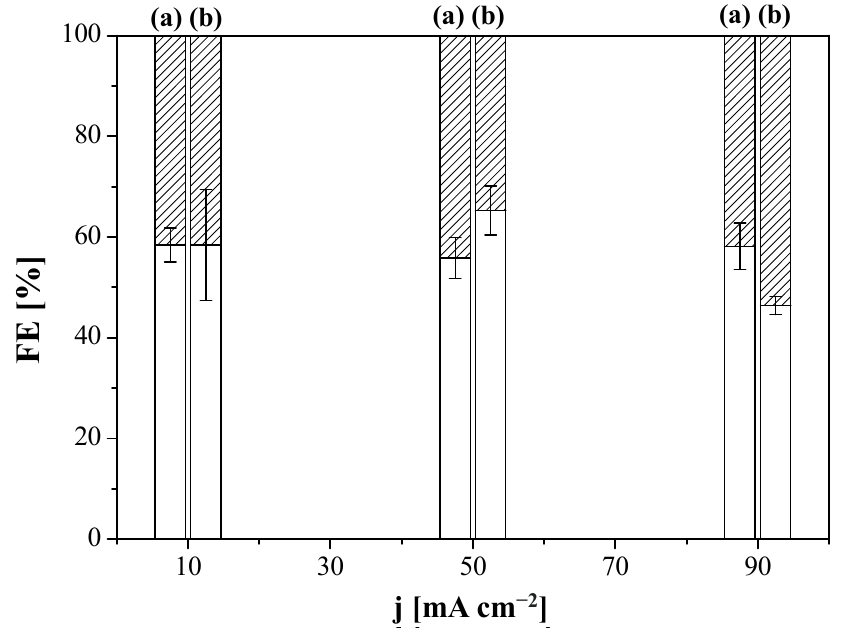
Figure 5. Faradaic efficiency (FE) of H 2 (striped) and C 2 H 4 (blank) obtained for the system with purely CS-based MEAs using the CS:PVA composite membrane (a) or the CuUZAR-S3@CuY/CS:PVA composite membrane (b) as compartment separator, as a function of applied current density. The electrode used in both cases was the Cu:CS